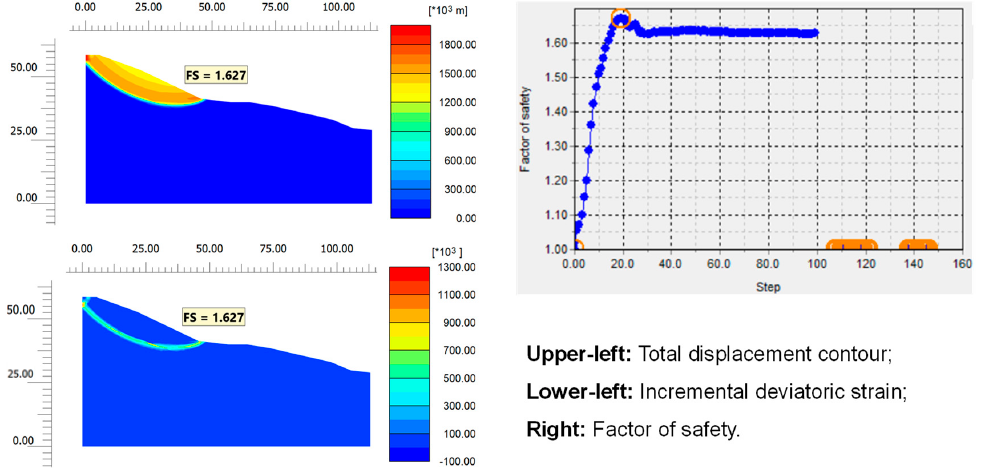
Figure 6. Calculation of FS of the case without vegetation root reinforcement and rainfall.